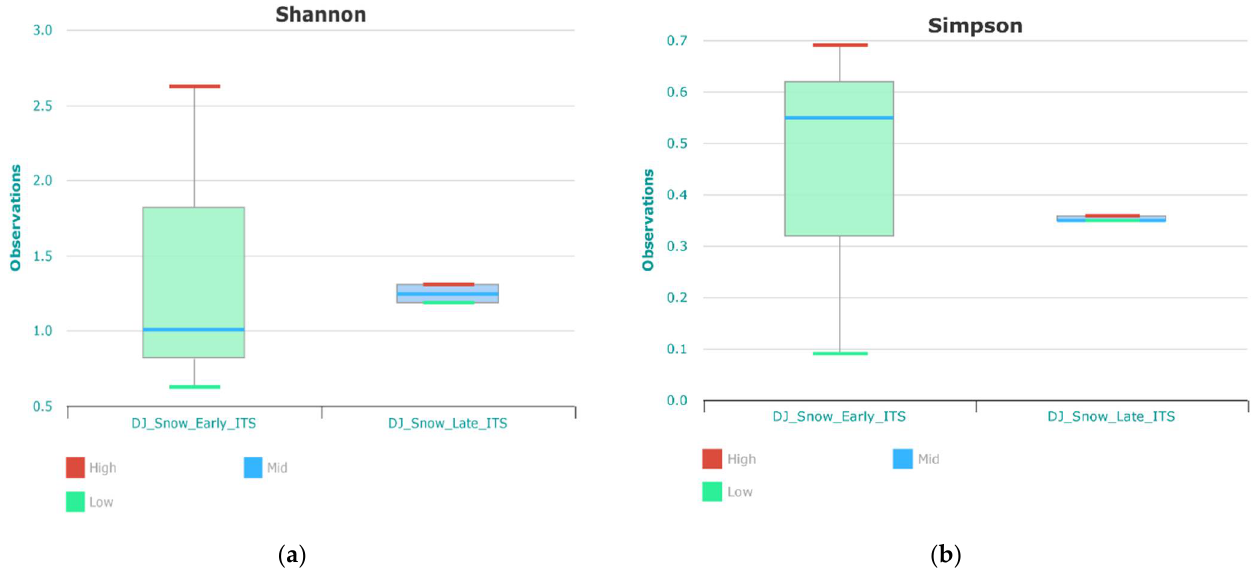
Figure 4. Comparison of diversity indices of ITS in the early season fresh snowfall samples DJS-1, DJS-2, and DJS-3 with the late season samples DJS-4 and DJS-5. ( a ) shows the Shannon diversity index during early season and late season snowfall while ( b ) shows the Simpson diversity index during early season and late season snowfall.